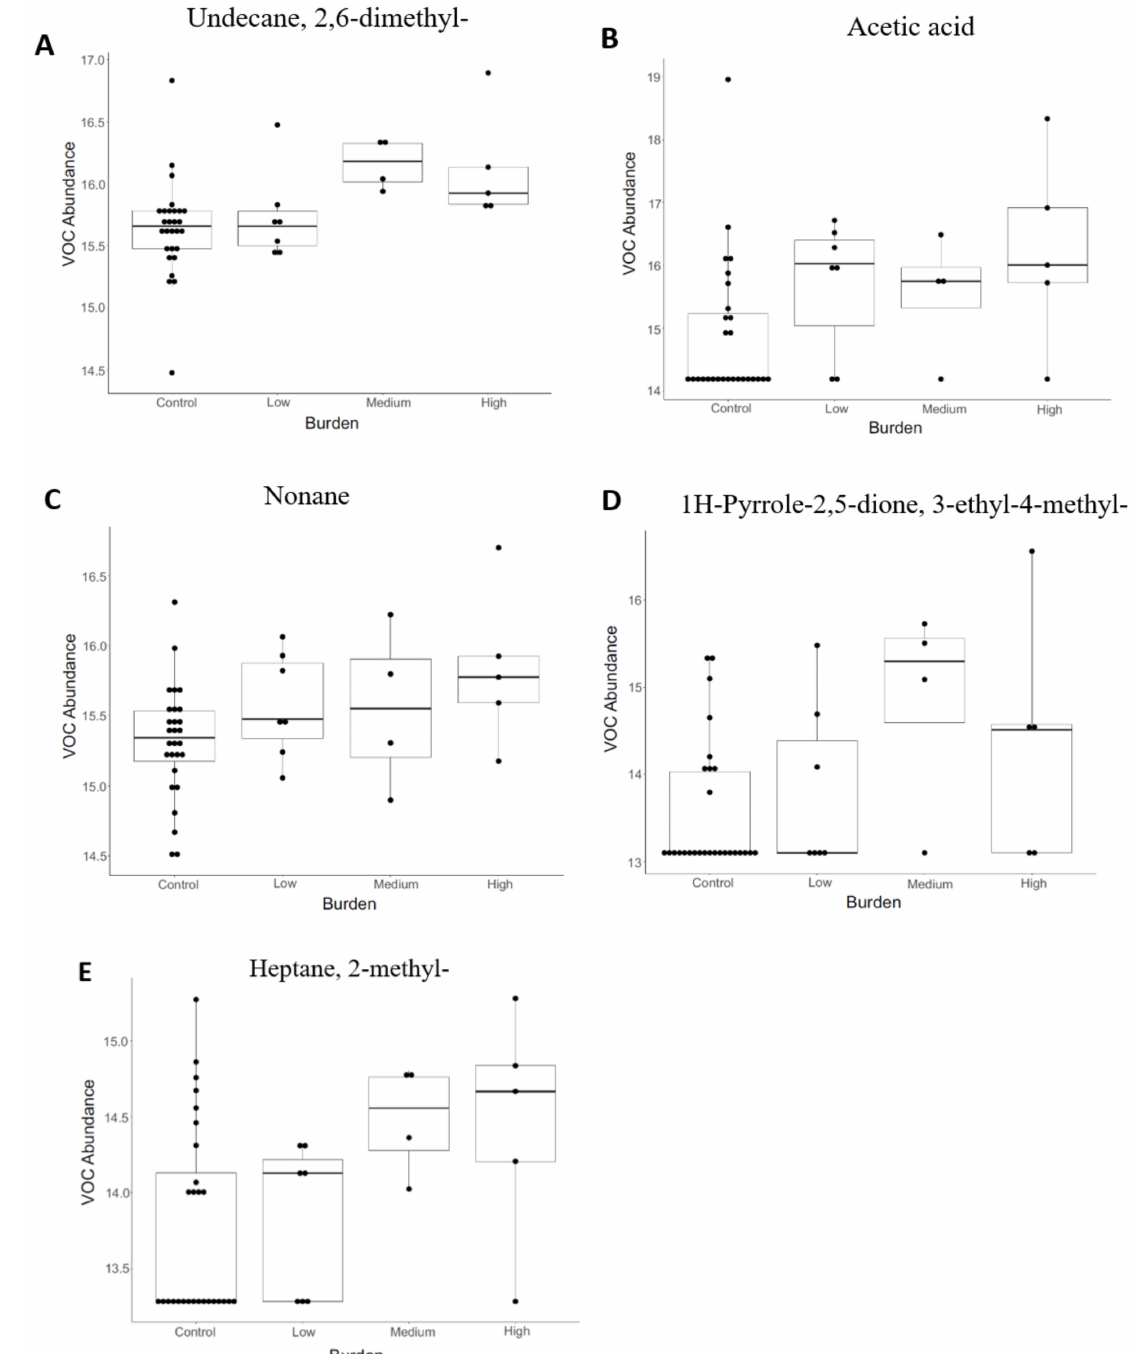
Figure 4. Box and whisker plots of VOC abundance of the colonic contents of horses infected with Anoplocephala perfoliata and non-infected controls. The three volatile organic compounds (VOCs) with the smallest p -values, identified by t -test for both TP vs. CO ( A – C ) and TP_21 vs. CO ( A , D , E ) are shown. Plots were constructed to show VOC abundance change in individual groups: control, low (1–20 worms), medium (21–49 worms) and high ( ≥ 50 worms) to show gradient change of compounds with level of tapeworm